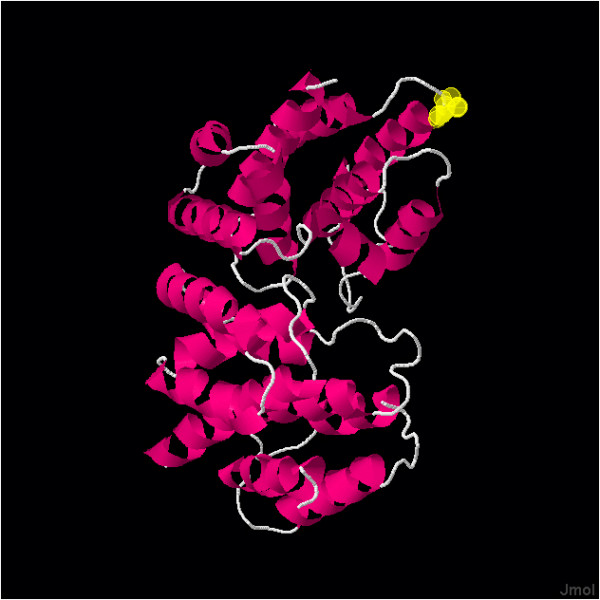
3D crystral structure of M1. The figure was generated using BioHealthBase. M1 is identified as dimers. Site at position 219 (yellow circles), which is under positive selection for human influenza, is located at the edge of the structure.